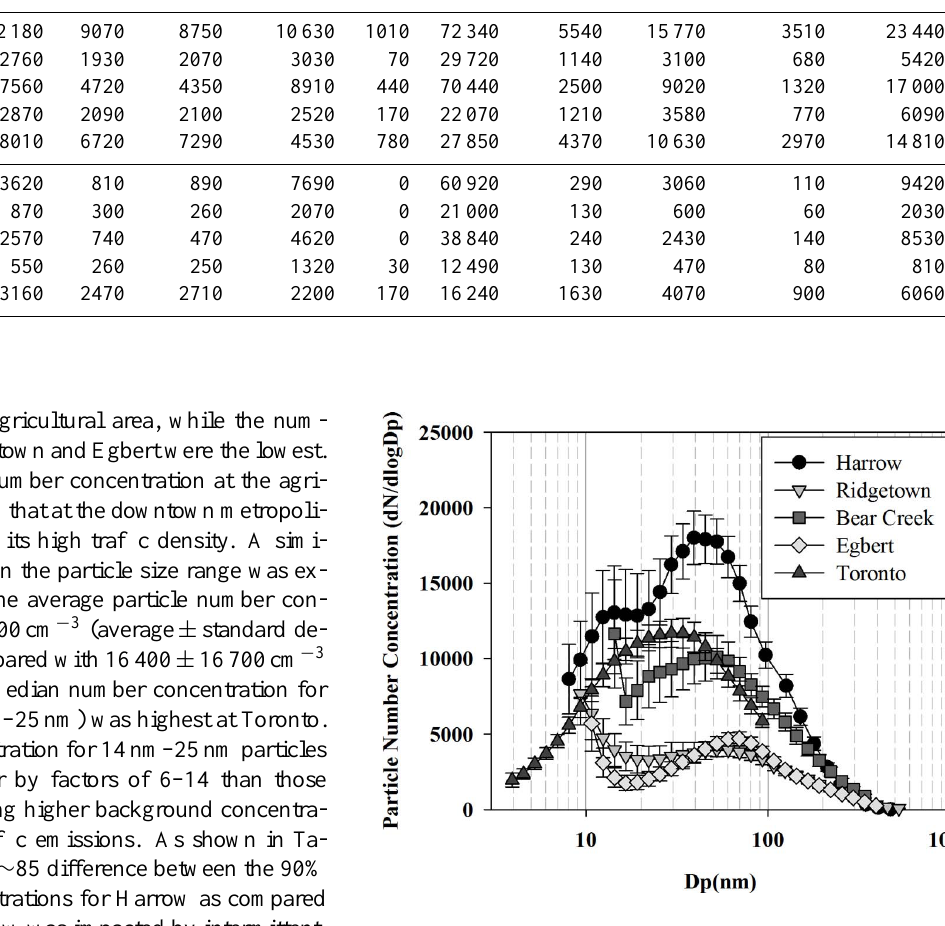
Fig. 3. Average particle size distributions at the five sites. Error bars represent standard errors.